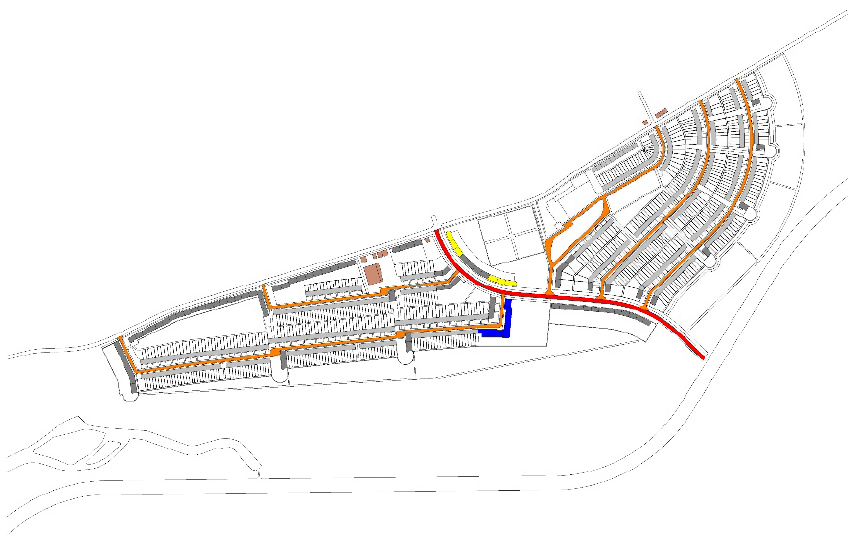
Figure 23. Formal structure, Siedlung Römerstadt. Drawings by Manlio Michieletto. main constitutive element, replacing the central green square (Figure 23). The same pattern has been ap- plied in the Siedlung Praunheim, where the Anger be- comes the Urtyp of the formal structure (Michieletto, 2011c). The Damaschkeanger spine running from the north to the south side of the Settlement governs the architectural elements composition (Figure 24). Even